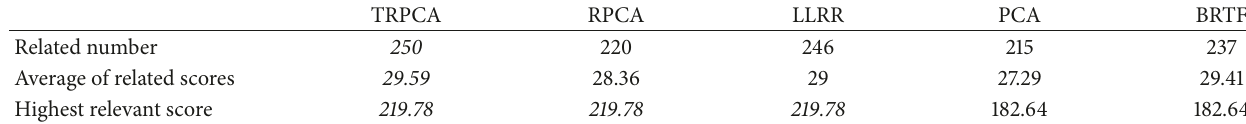
Table 6: Relevance